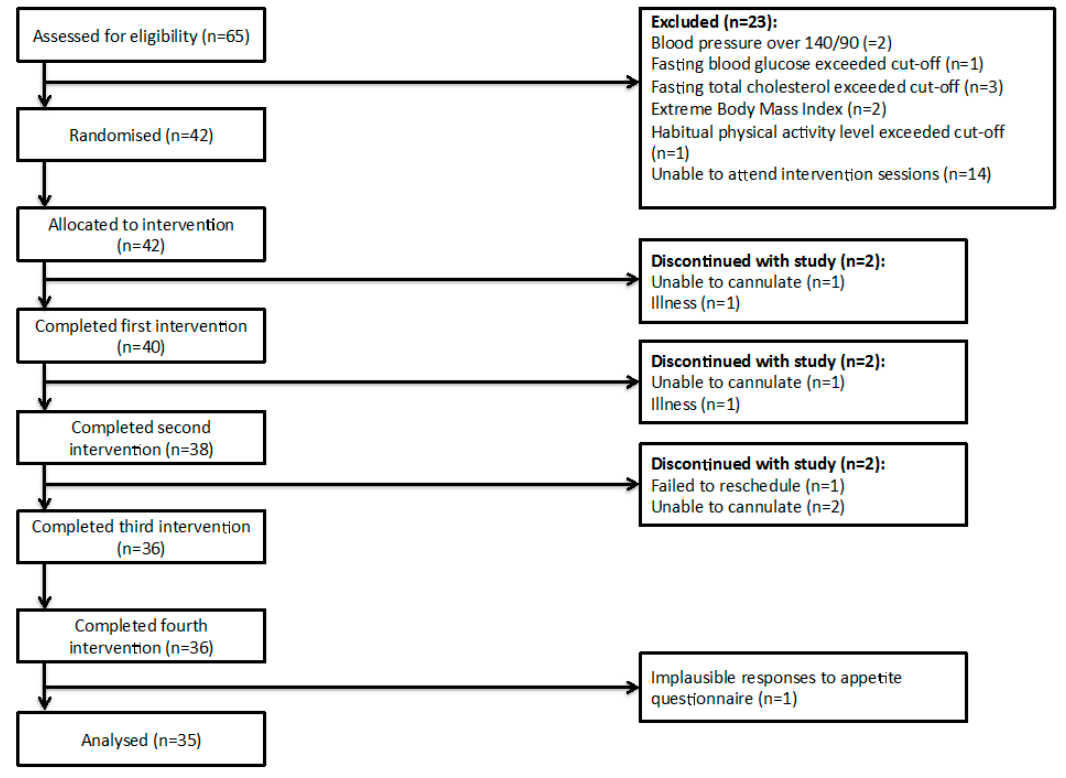
Figure 2. Consort diagram. Table 2. Participant baseline